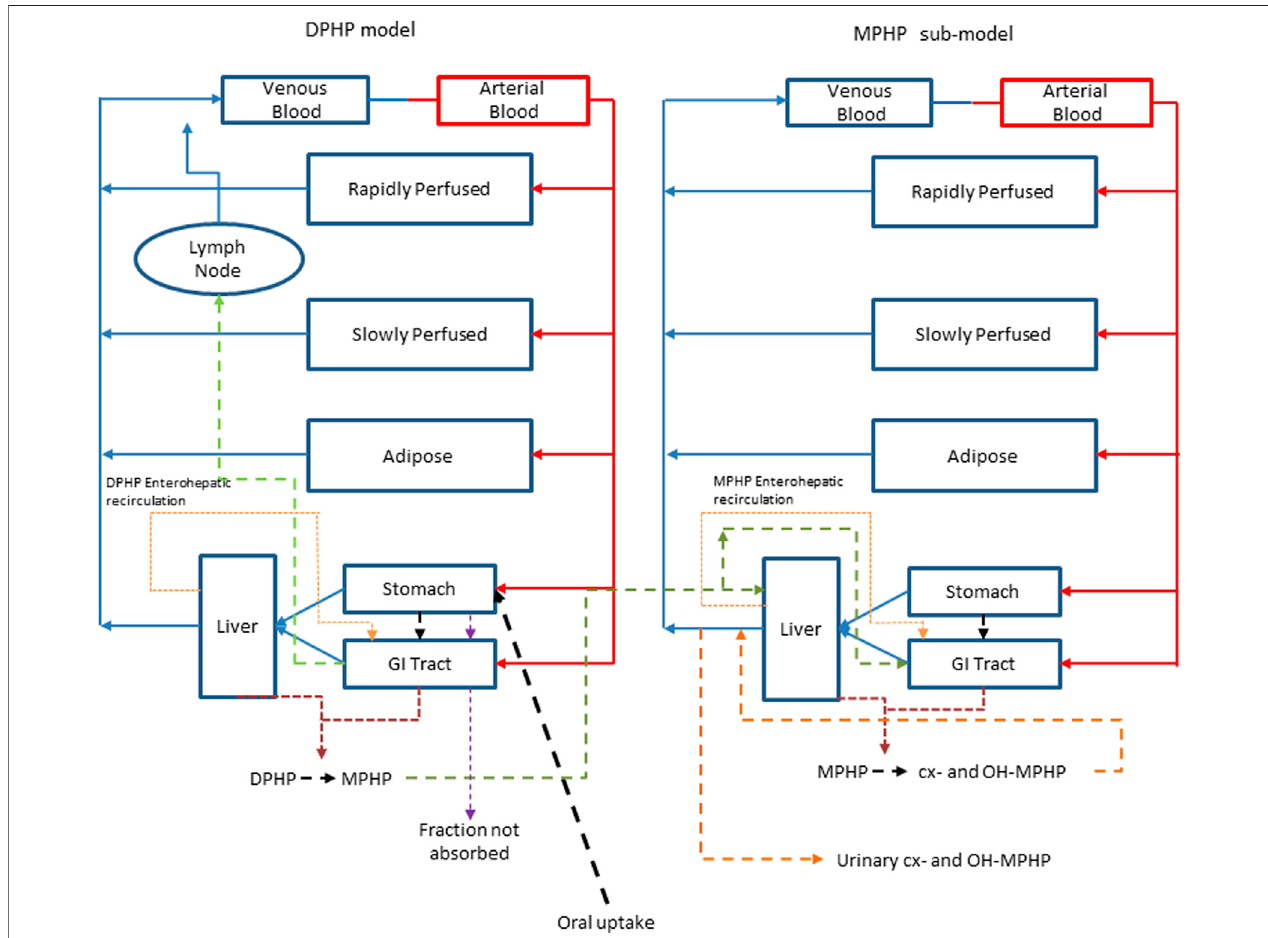
FIGURE 2 | A schematic of the model for DPHP and sub-model for MPHP. The main model contained a lymphatic compartment which received a portion of oral dose from the stomach and GI tract. Urinary excretion of metabolites was ascribed to the sub-model.